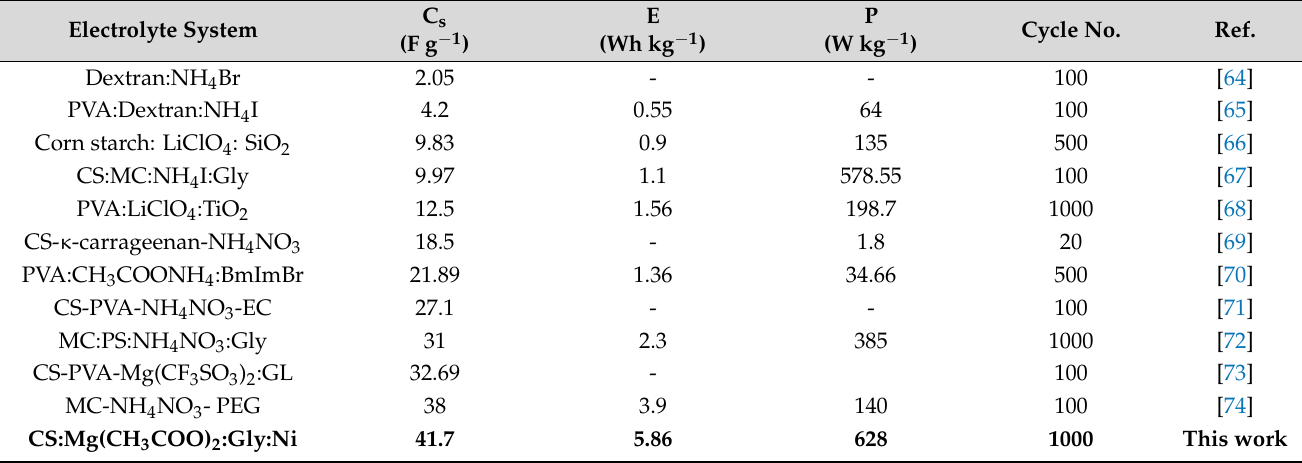
Table 4. General performance of the fabricated EDLC device compared to the other EDLC devices based on various polymer electrolytes in terms of specific capacitance (C s ), energy density (E), power density (P) and cycle number. Electrolyte